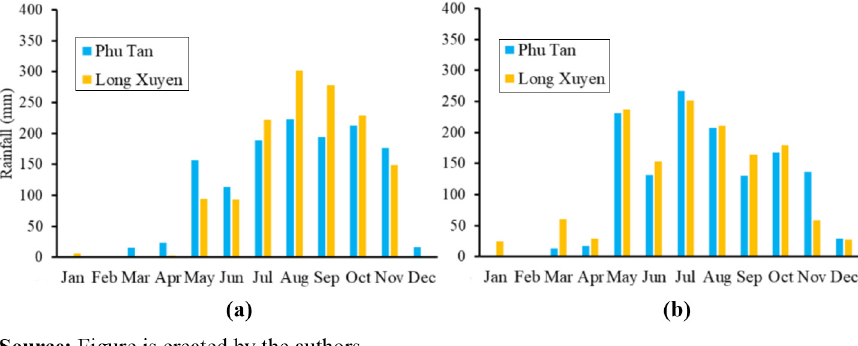
Figure 2. Precipitation data